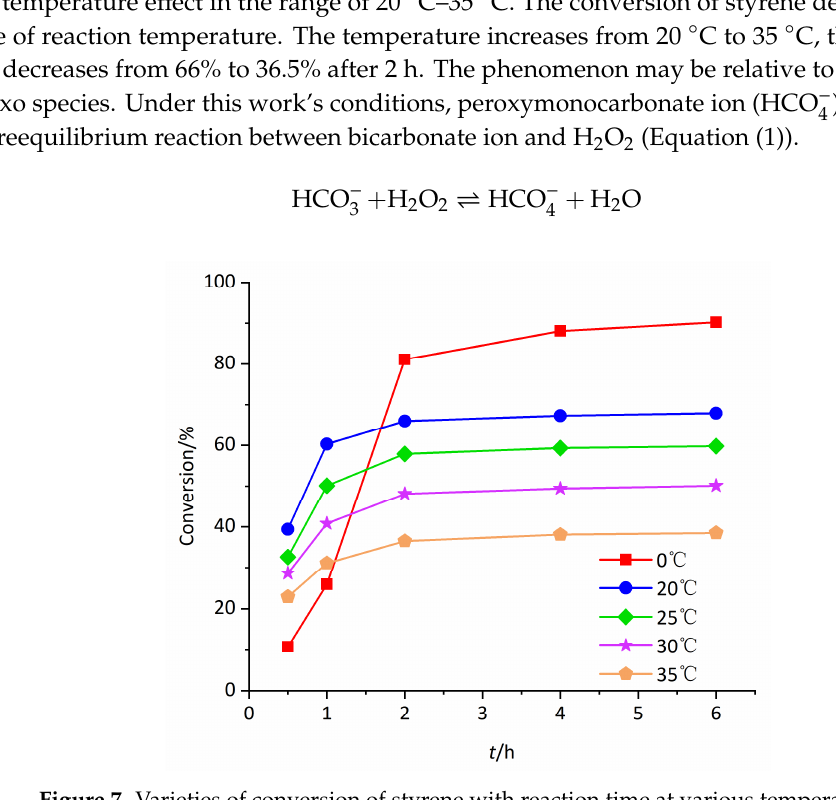
Figure 7. Varieties of conversion of styrene with reaction time at various temperatures.